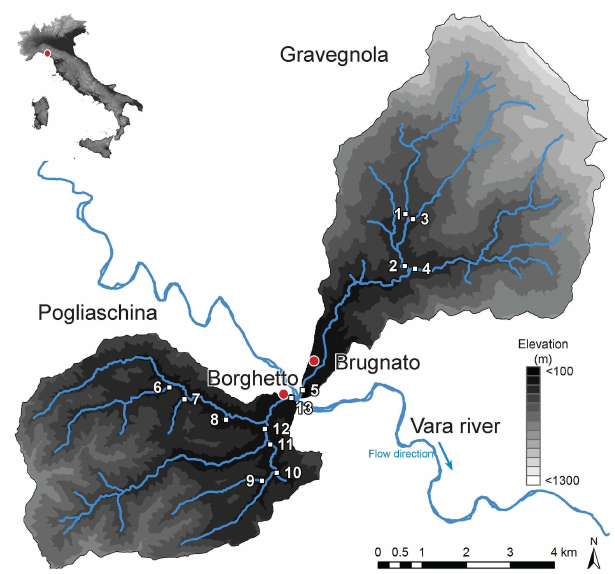
Figure 2. Geographical location and Digital Elevation Model (DEM) of the Pogliaschina and Gravegnola basin. The studied chan- nels have been indicated with a number at their outlets: 1. Casserola 1, 2. Casserola 2, 3. Suvero, 4. Veppo, 5. Gravegnola, 6. Pogliasca, 7. Redovego, 8. Sottano, 9. Ginepro, 10. Benoia, 11. Redarena, 12. Cassana, 13.